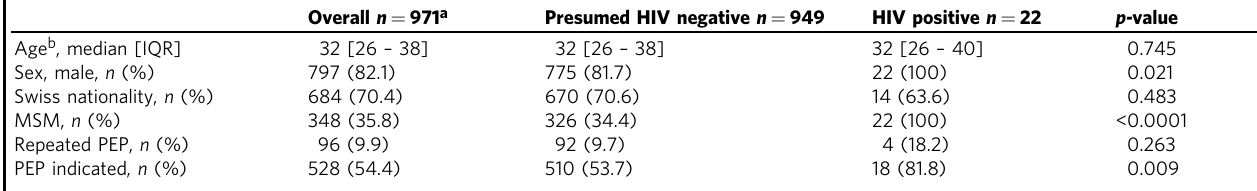
Table 1 Characteristics of individuals seeking PEP at the University Hospital of Zurich between 2007 and 2013.